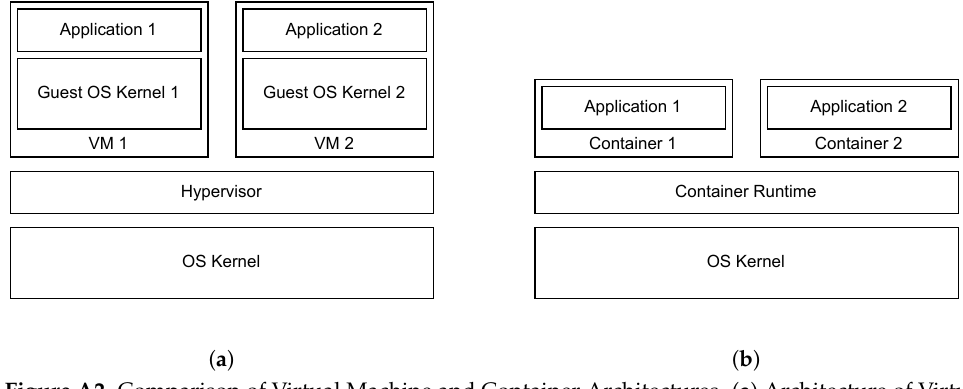
Figure A2. Comparison of Virtual Machine and Container Architectures. ( a ) Architecture of Virtual Machines. ( b ) Architecture of